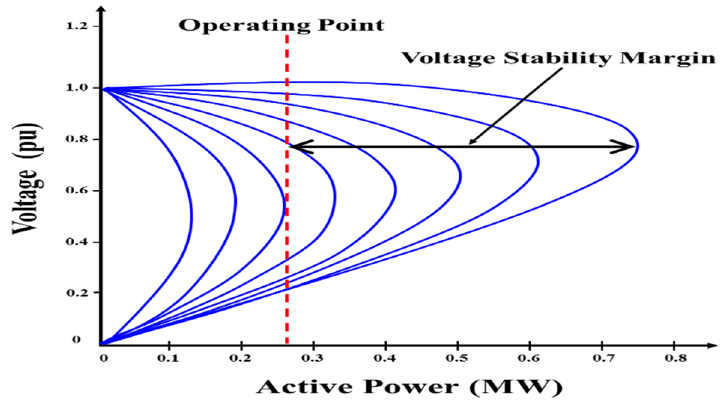
Figure 9. Voltage stability margin with PV curve.